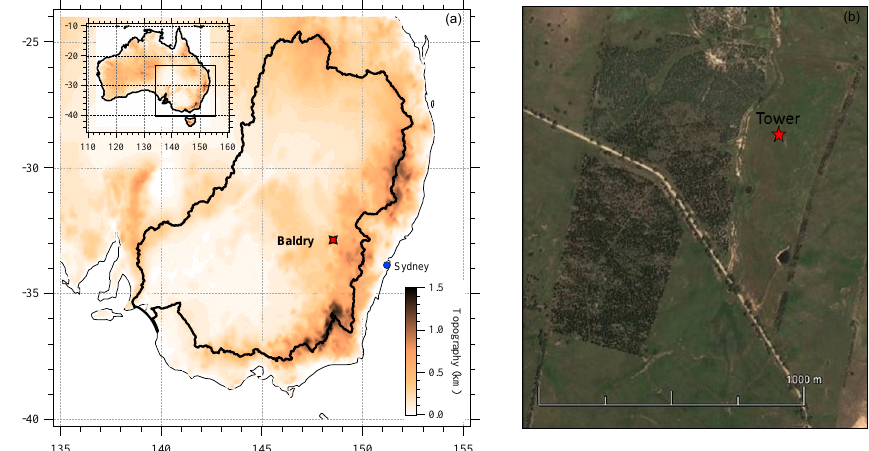
Figure 1. (a) Location of the Baldry Hydrological Observatory, with the heavy black border outlining the extent of the Murray–Darling Basin, (b) location of the field site used for the campaign, illustrating the semi-arid grassland and adjacent reforested